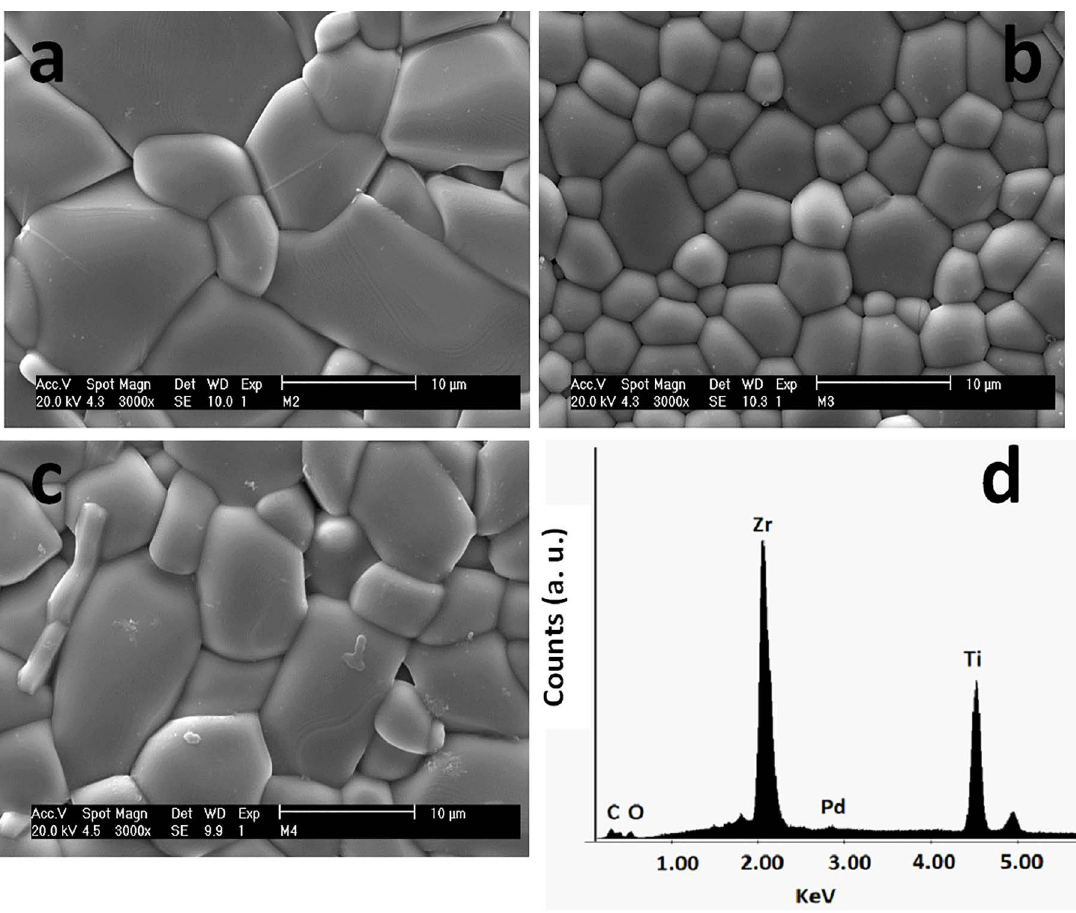
after 7 (a), 14 (b) and 21 days (c) of immersion in SBF without 4